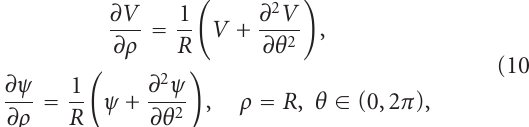
and bending sti ff ness K o b , respectively. In order to choose δ σ b and δ K b , it is necessary to specify how the imperfect blades behave during the homogenization limit. For the sake of example, it is assumed that the j th blade of the rotor is imperfect, with increased linear mass density equal to σ o b + δ σ bj as indicated in Figure 2. When the number of blades is increased to approach the homogenization limit, the number of imperfect blades increases as depicted in Figure 2, and their mass density and bending sti ff ness are rescaled according to the conditions given in Section 2.2. In particular, at the k th homogenization-process step, the total number of blades becomes N = 2 k N b , and the blade linear mass density and bending sti ff ness are rescaled by a factor 1 / 2 k with respect to their nominal value; on the other hand, the number of imperfect blades becomes 2 k , with rescaled linear mass density variation equal to δ σ bj / 2 k